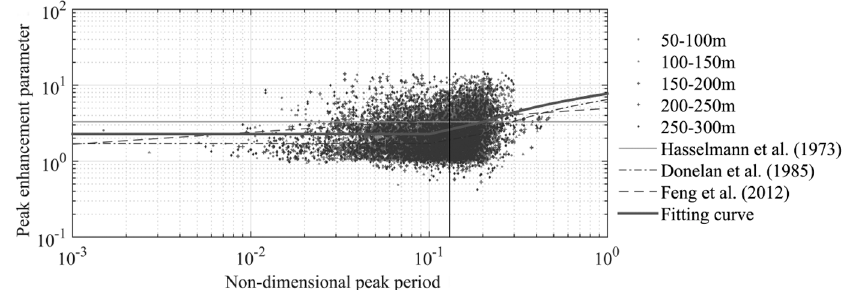
Figure 10. Values of γ as a function of ν for normal condition from 1999 to 2014. The average 3.3 and 2 empirical Equations (24) and (26) proposed by Hasselmann (1973) [11], Donelan et al., (1985) [15] and Feng et al., (2012) [27] are shown. The vertical line drawn at υ = 0.13 marks the commonly adopted boundary between swell and wind wave.